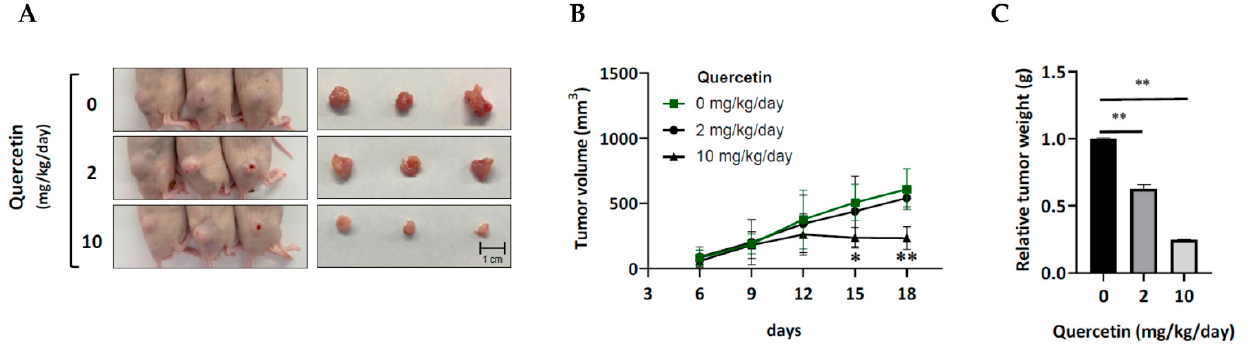
Figure 3. Quercetin suppresses tumor growth of erlotinib-resistant HSC-3 cells in vivo. ERL-R5 cells were subcutaneously injected into the dorsal flank of male nude mice, and quercetin (0, 2, 10 mg/kg/day) was administrated with intraperitoneal injection ( n = 6 per group). ( A ) The images represented the tumor volume and tumor size in control and two quercetin-treated groups before and after mice were sacrificed, respectively. ( B ) The growth curve of tumor volumes was examined and ( C ) tumors were excised and weighed at the end of the experiment. A two-way ANOVA followed by Tukey’s test was used to assess the differences of tumor volume and weight between the control and quercetin groups (* p < 0.05, ** p <